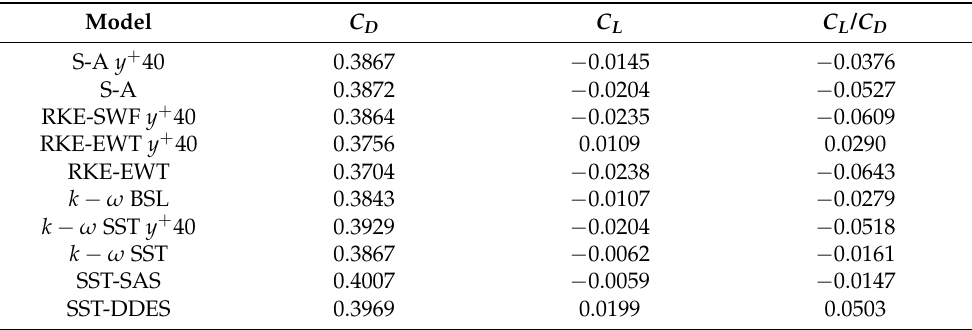
Table 1. Values of drag coefficient ( C D ), lift coefficient ( C L ) and their ratio ( C L / C D ) for different turbulence